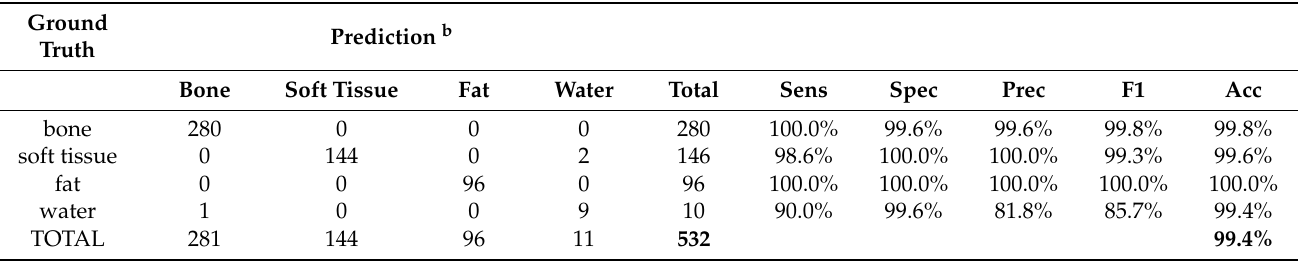
Table 3. Confusion matrix and detailed test performance characteristics a of the final ensemble